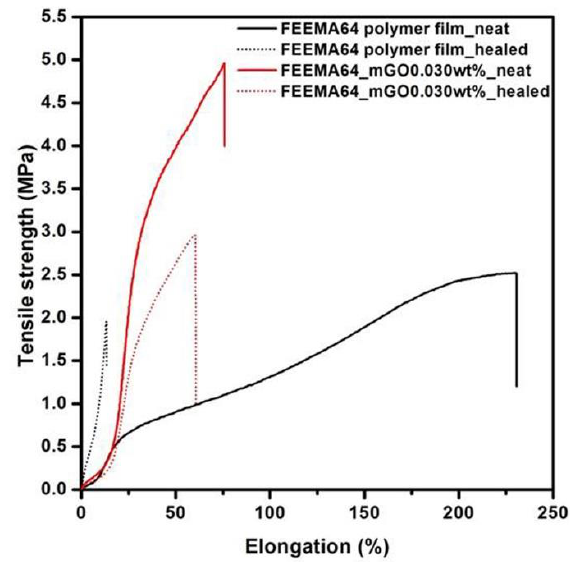
Figure 7. Stress-strain curves of neat and healed samples for FEEMA64 polymer film and FEEMA64_mGO0.030 wt%.